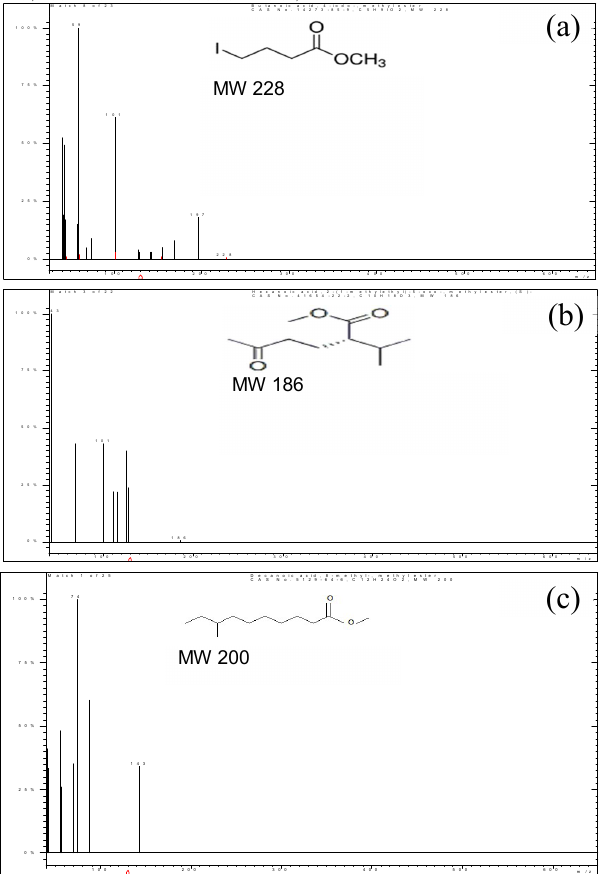
Figure 14. Mass spectra of ( a ) Butanoic acid, 4-Iodo-, methyl ester; ( b ) Hexanoic acid, 2-(1-methylethyl)-5-oxo-, methyl ester; ( c ): Decanoic acid, 8-methyl-, methyl